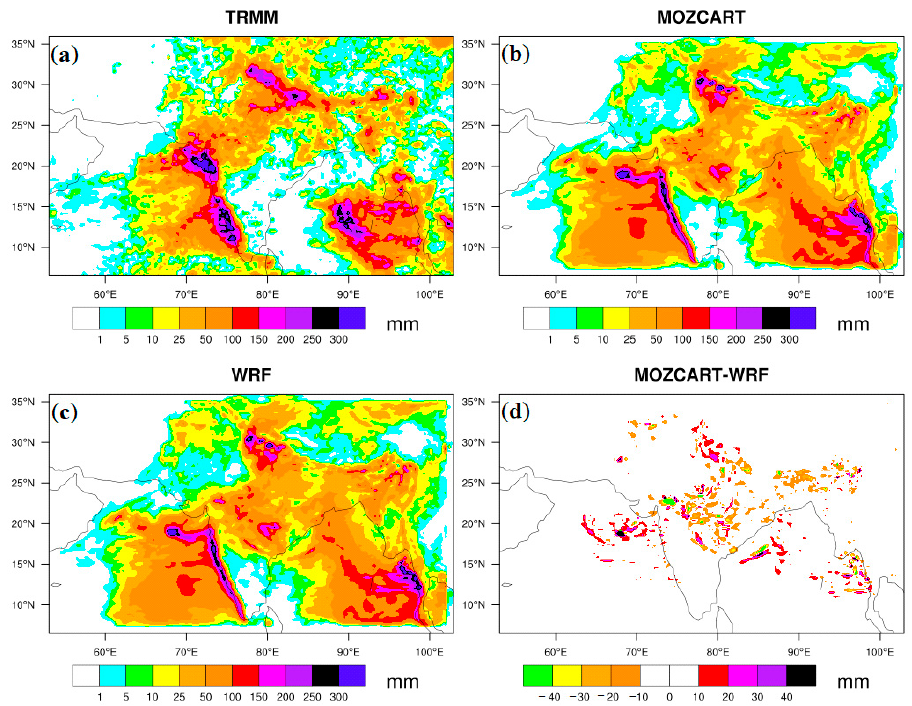
Figure 1. Three days accumulated rain from ( a ) TRMM and those from the WRF simulations ( b ) WC25 and ( c ) WRF25 and ( d ) the difference in rainfall between WC25 and WRF25.